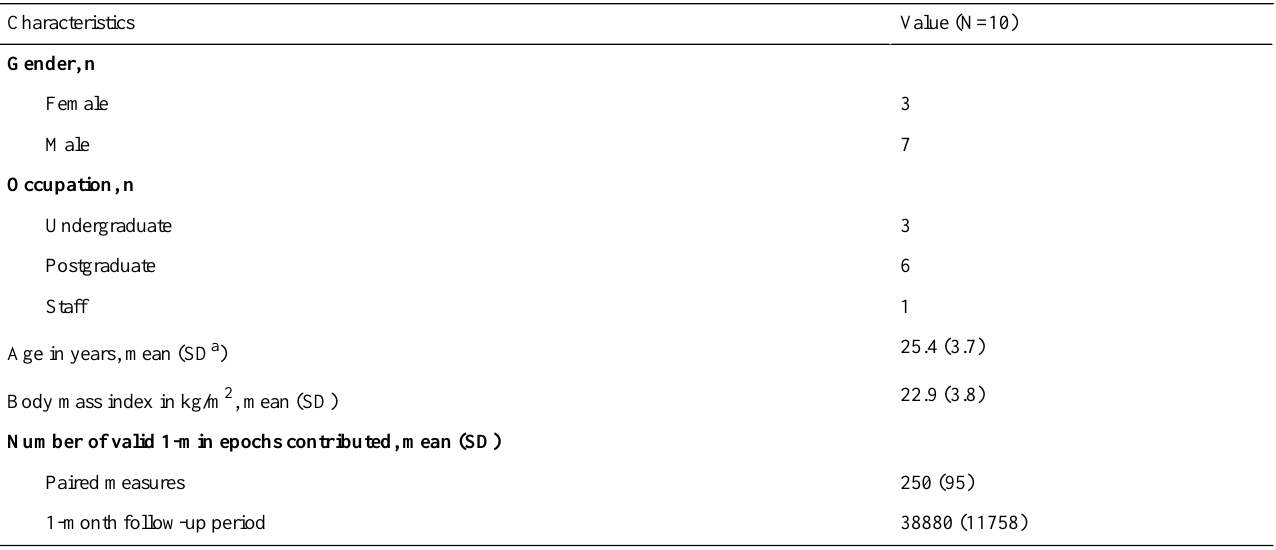
Table 1. Sample characteristics (N=10).